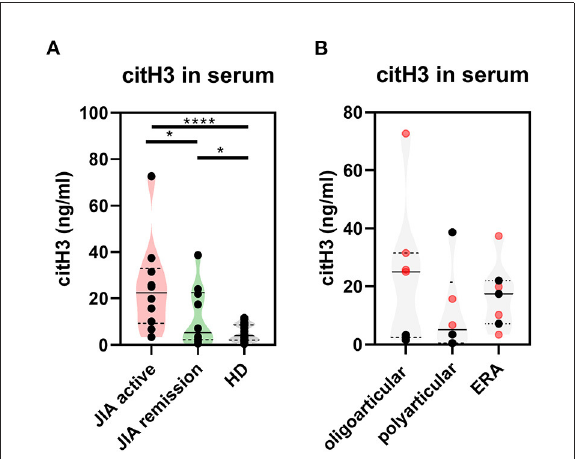
FIGURE1 Citrullinated histone H3 in JIA. (A) Serum levels of citrullinated histone H3 (citH3) in JIA active ( n = 10), JIA remission ( n = 10), and healthy donors ( n = 26) were detected using ELISA. (B) citH3 levels were compared between the groups. Patients with JIA active (in red) and JIA remission (in black) were divided, according to JIA subtypes, into oligoarticular/oligo-extended, polyarticular, and ERA (enthesis-related arthritis) groups. Values are standardized and expressed as median values. Statistical analyses were performed using unpaired t -tests. Values of p < 0.05 (*), p < 0.01 (**), p < 0.001 (***), and p < 0.0001 (****) were considered statistically significant.